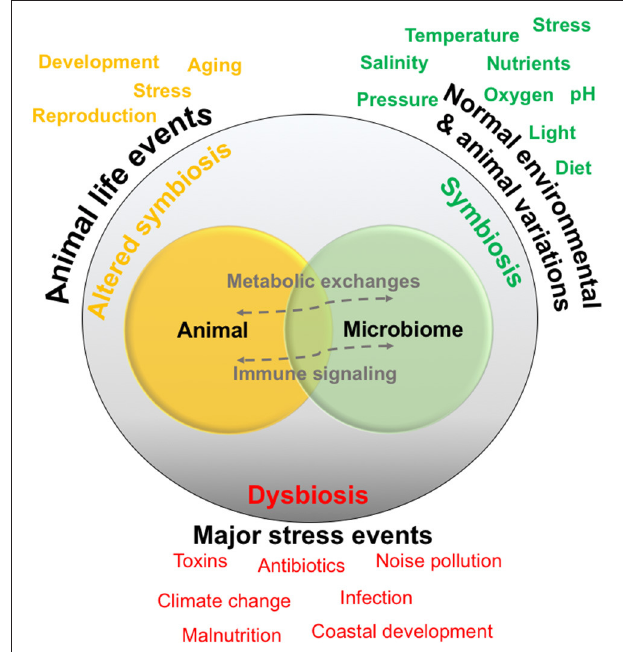
FIGURE 2 | Conceptual diagram of a host-microbiome relationship. Relationships are generally thought to exist in a symbiotic state, and are normally exposed to environmental and animal-specific factors that may cause natural variations. Some events may change the relationship into a functioning but altered symbiotic state, whereas extreme stress events may cause dysbiosis or a breakdown of the relationship and